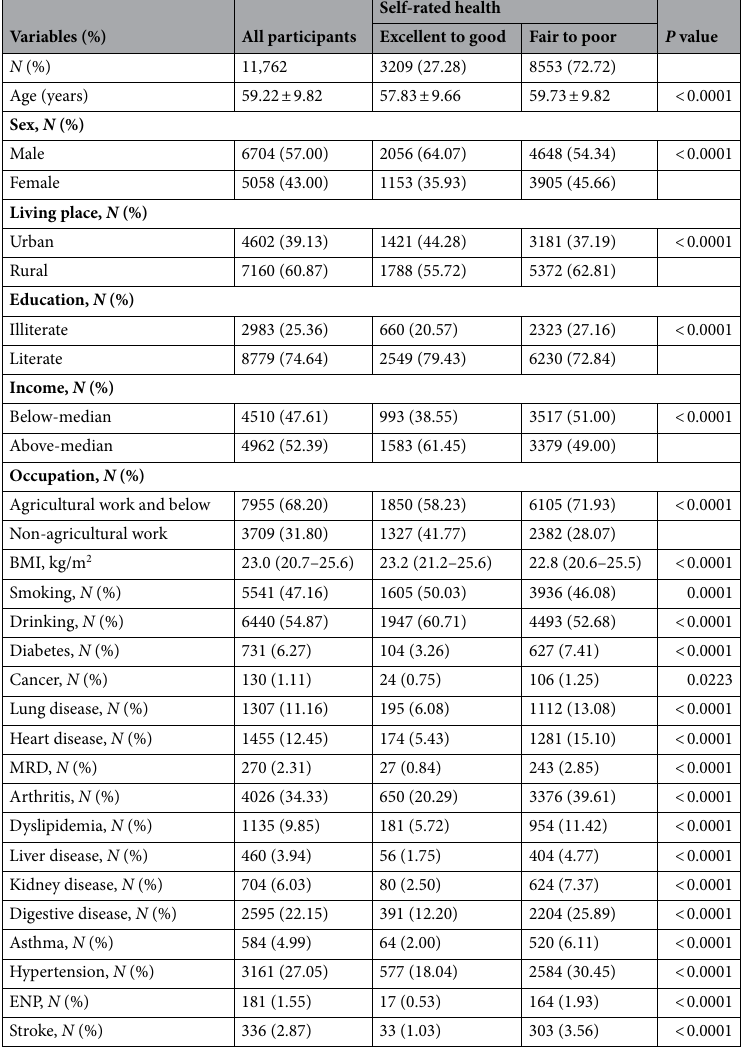
Table 1. Characteristics of the study population. MRD, memory-related disease; ENP, emotional, nervous, or psychiatric problems. Values were presented as mean ± SD, n (%) or median (25th–75th